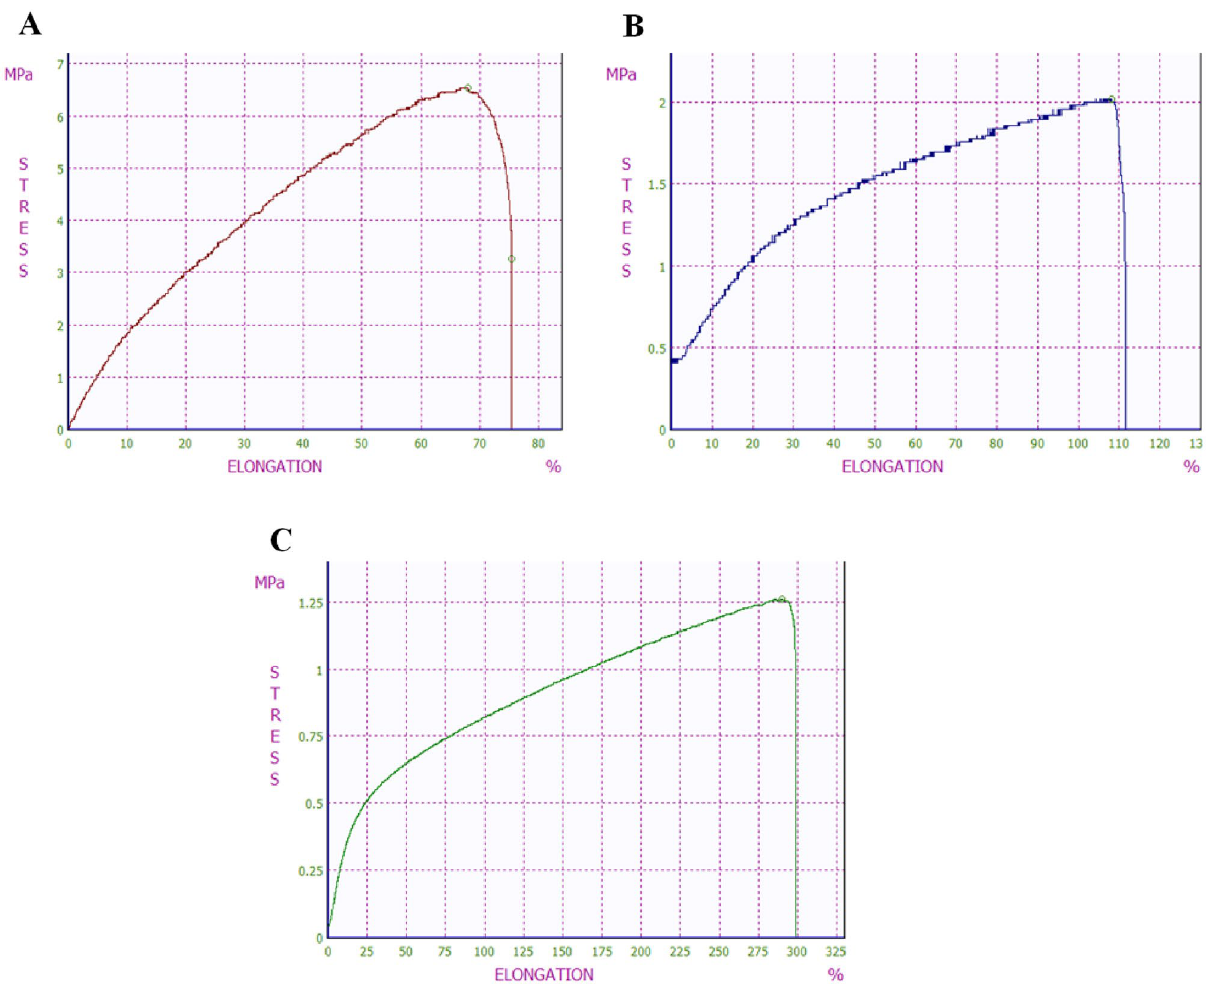
Figure 1. The tensile strength test charts of ( A ) 5%, ( B ) 7.5%, and ( C ) 10% PCL solutions.